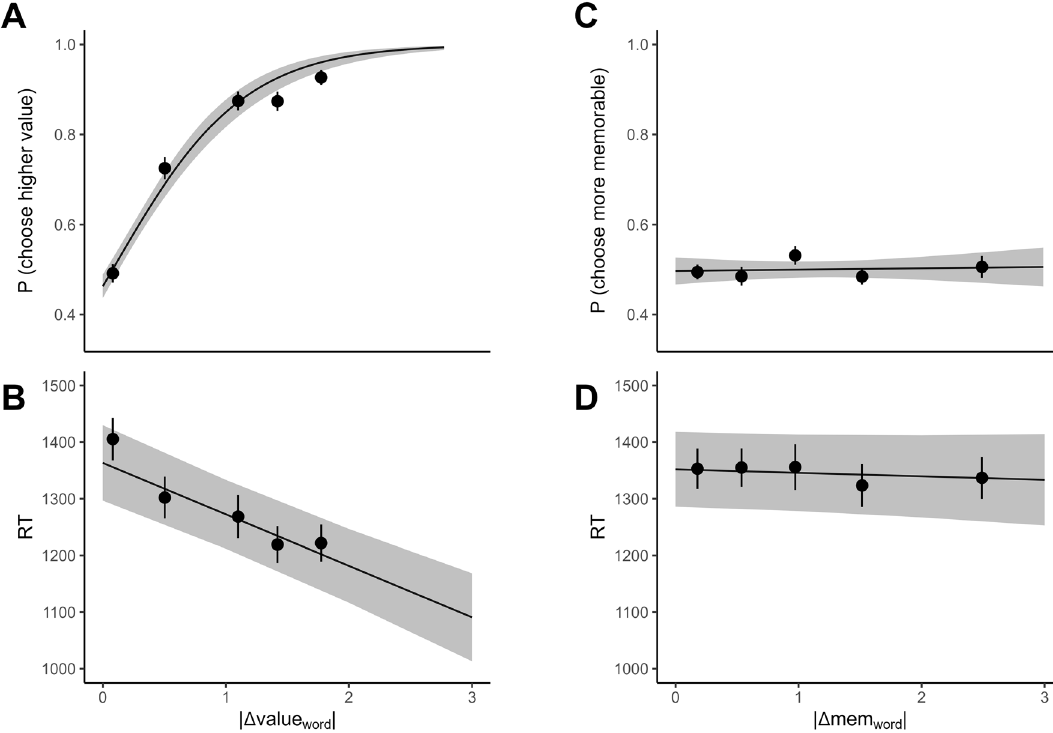
Figure 6. Subjective value, but not word memorability, relates to choice behavior and speed. The proportion of more-valuable item choice ( A ) and RT ( B ) plotted as a function of |Δvalue word | for trials where |Δmem word | was low or near zero. The proportion of more-memorable item choice ( C ) and RT ( D ) plotted as a function of |Δmem word | for trials where |Δvalue word | was low or near zero. All of the models had 3080 trials. In each plot, the solid black line represents the predicted regression line. The shaded gray area represents the 95% confidence intervals. The trial data were binned into 5 equal-sized bins on the x-axis. The black dots represent the mean proportion of choosing a higher-valued item (top-left), choosing the more memorable item (top-right), or mean RT (bottom) across participants within bins. Error bars are standard error of the mean across participants within